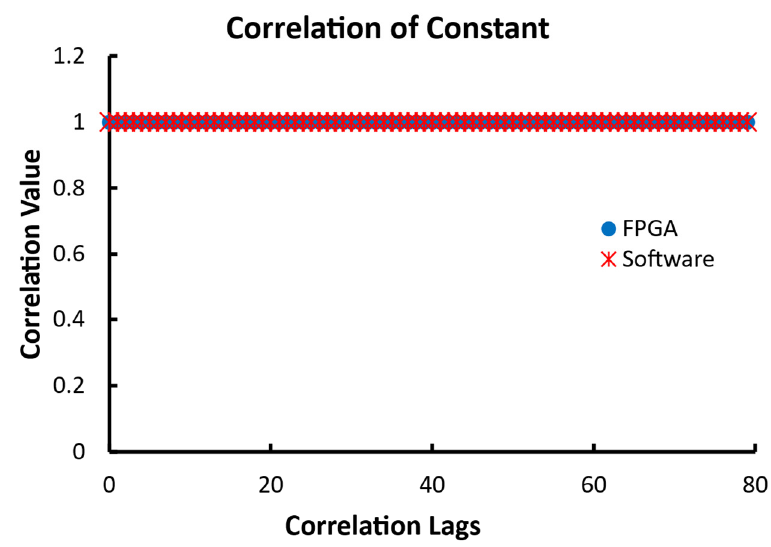
Figure 12. The outputs of 80 correlation lags from the linear FPGA correlator and the linear software correlator when the input data are constants of 1.